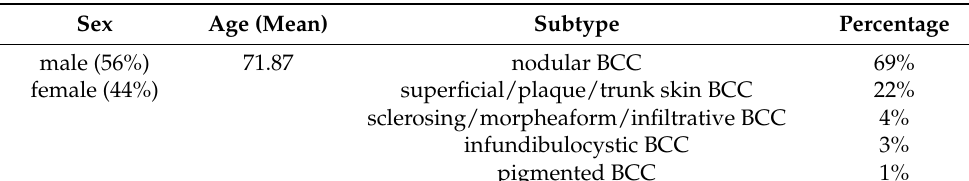
Table 1. Baseline characteristics of patients and tumor subtypes.